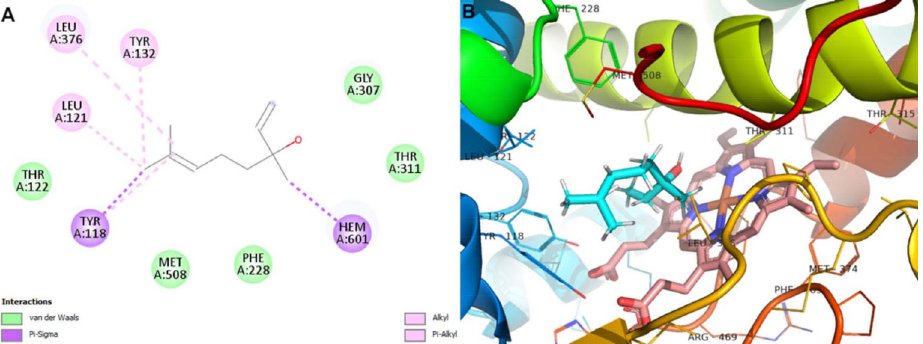
Figure 5. Molecular docking analysis. A , Two-dimensional interactions. B , Three-dimensional representation of linalool interactions in the lanosterol 14 a -demethylase active site.